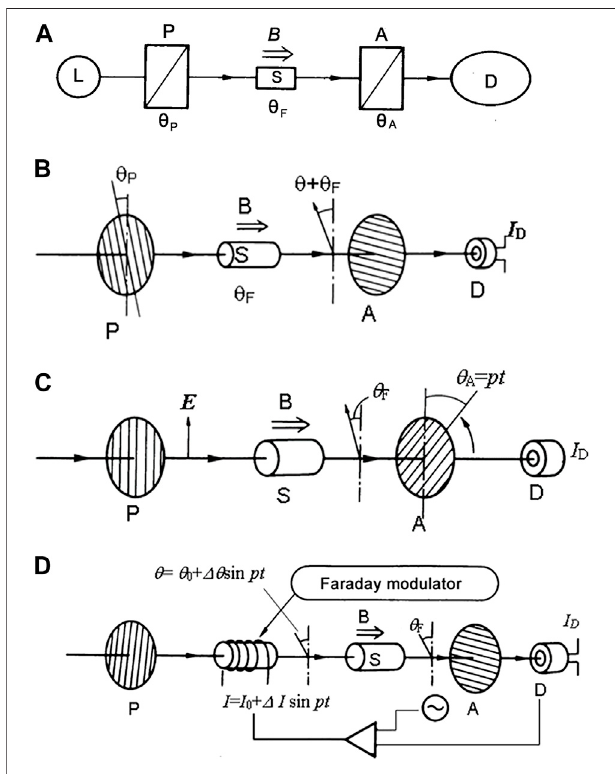
FIGURE 9 | Magneto-optical measurement technique (A) Orthogonal polarizer technique L: light source, p : polarizer, S: sample, A: analyzer, D: detector (B) Rotating polarizer technique p : rotating polarizer (polarizing angle θ p , S: sample (Faraday rotation θ F ), A: analyzer, D: detector (C) Oscillating polarizer technique p : polarizer, S: sample, A oscillating analyzer, D: detector (D) Faraday cell technique p : polarizer, S: sample. A: analyzer, D: detector.